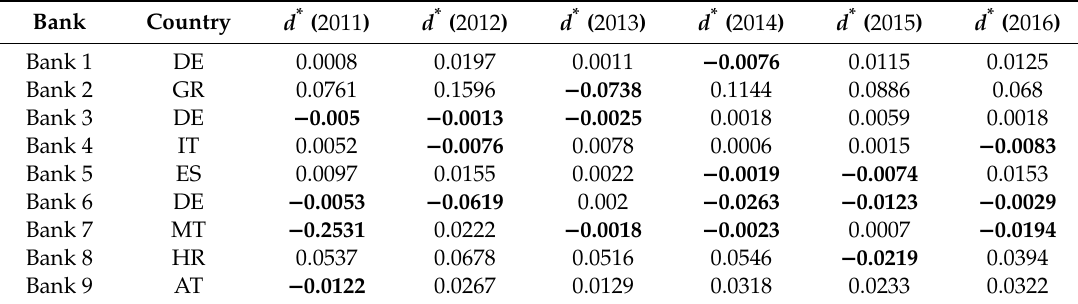
Table 6. The scores of the banks classified as e ffi cient at least once in